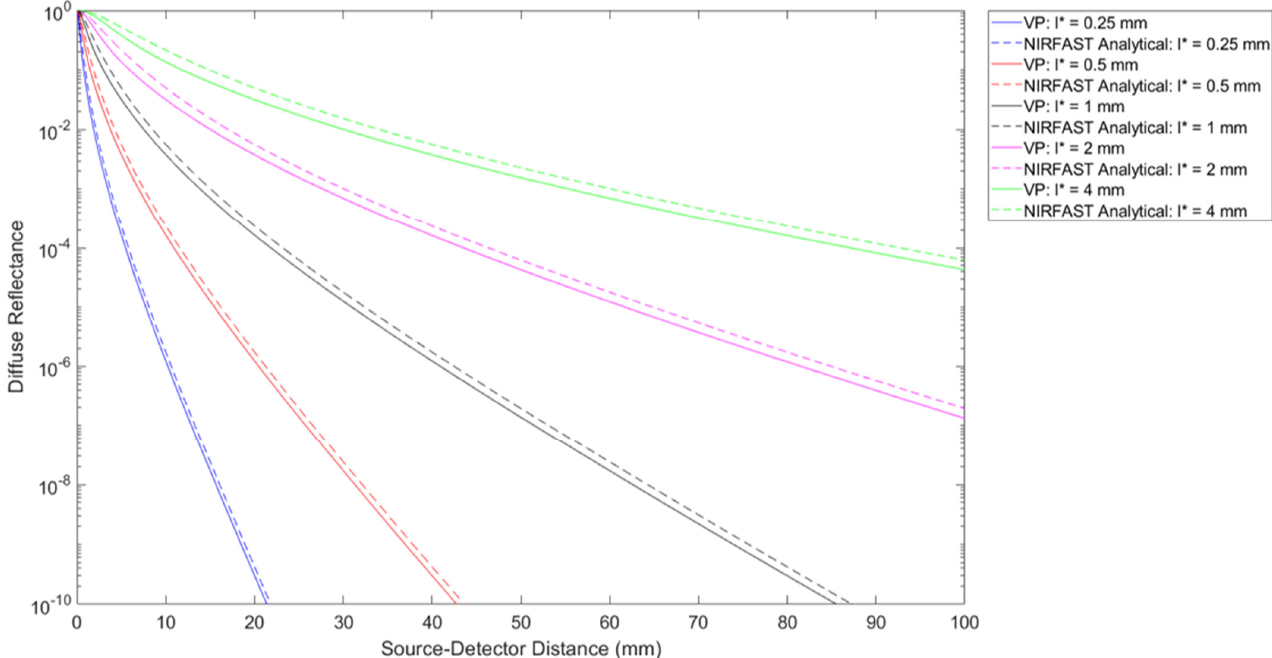
Figure 1. Diffuse reflectance versus source-detector separation distance for varying l* values, validating the NIRFAST semi-infinite analytical model against the virtual photonics solution. These reflectance plots are normalized to the nearest source-detector distance.